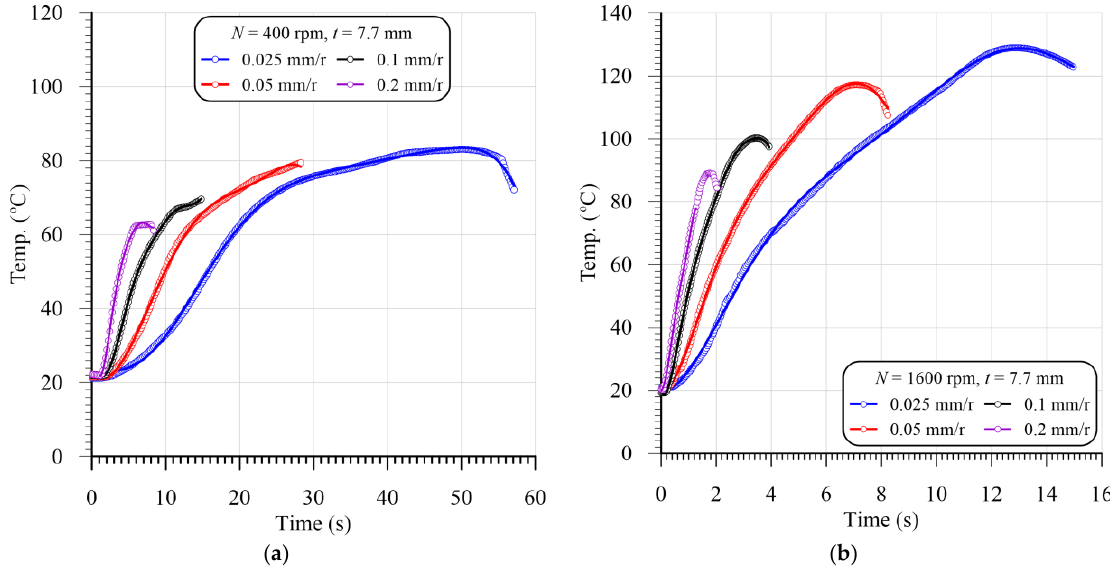
Figure 5. Representative samples of evolution of instrumented drill temperatures vs. cutting time in drilling GFRP composites with 7.7 mm thickness at different feeds and speeds of: ( a ) 400 rpm, and ( b ) 1600 rpm.